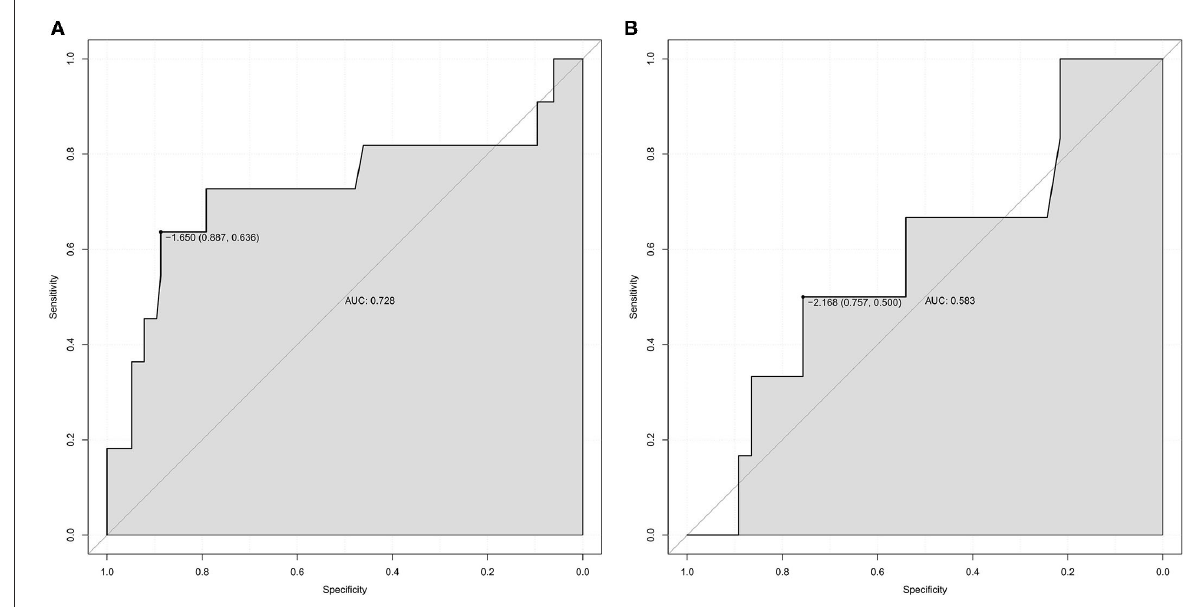
FIGURE5 (A) ROC curve of training set data. (B) ROC curve of testing set data.